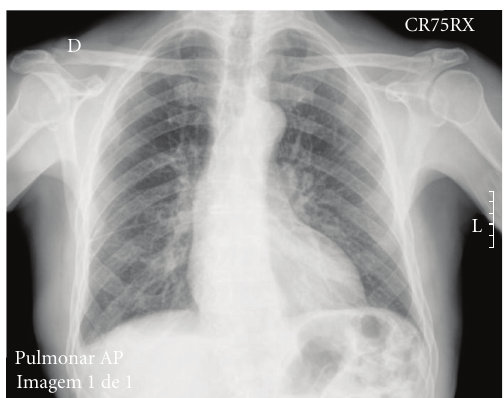
Figure 3: Chest X-ray one month after suspending the bromocrip-